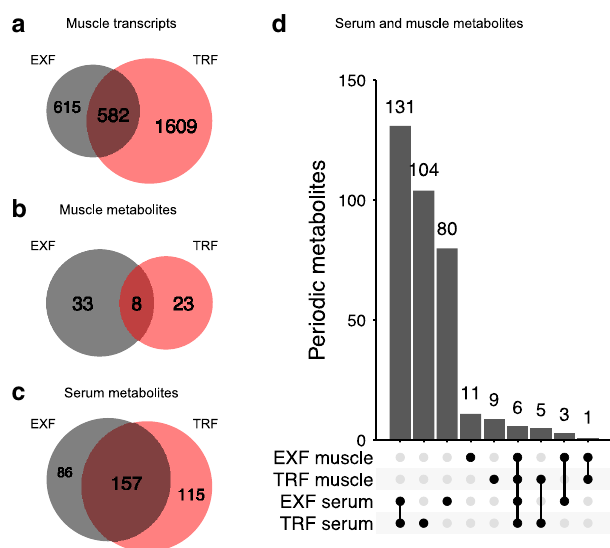
Fig. 2 Overlaps of signi fi cantly periodic features in serum and skeletal muscle. Periodic skeletal muscle transcripts ( a ), skeletal muscle metabolites ( b ), and serum metabolites after extended feeding (EXF) in gray ( c ), and time-restricted feeding (TRF) in light red. Comparison of periodic serum and skeletal muscle metabolites (with only relevant comparisons shown) ( d ). Vertical bars indicate set size, dots and lines indicate set identity, n = 11 participants.